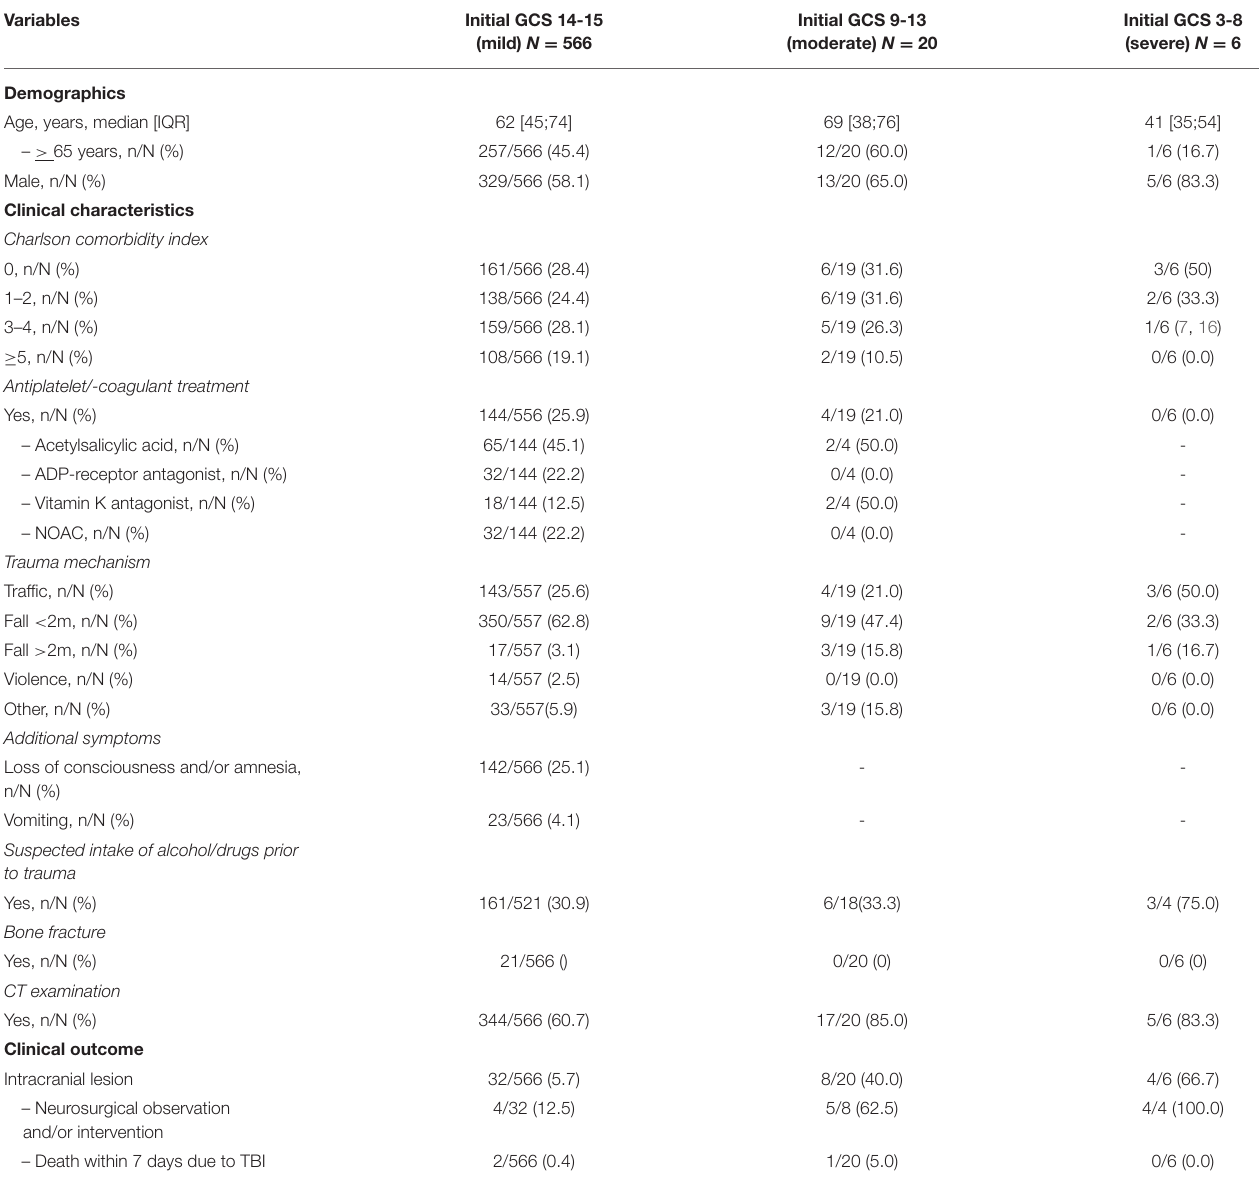
TABLE 1 | Demographics, clinical characteristics, and outcome data of the included patients with traumatic brain injury (TBI) stratified by the Glasgow Coma Scale (GCS), N = 592.